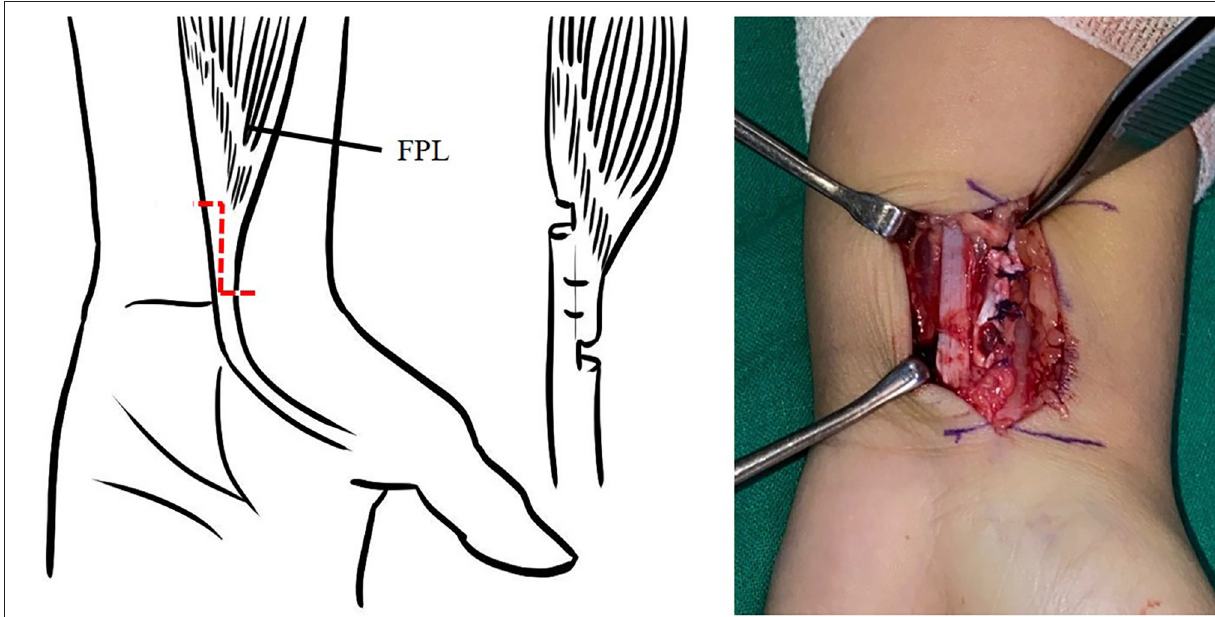
FIGURE 3 | Flexor pollucis longus lengthening.